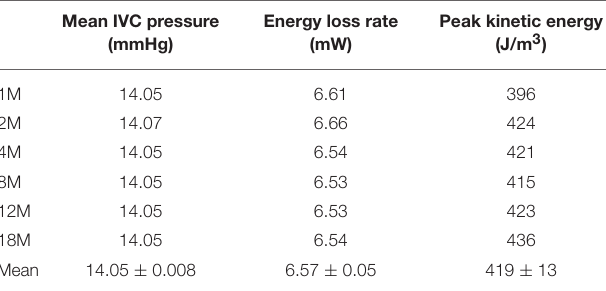
TABLE 3 | Performance of six realizations of the conventional Fontan, predicted on different CFD